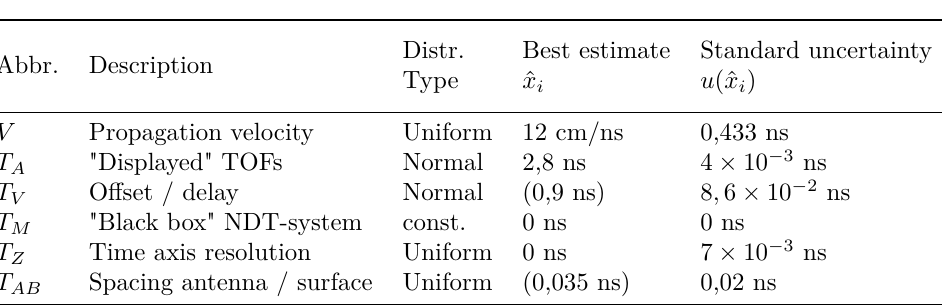
Table 1. Individual models of the input quantities used to compute the measurement result. The biases regarding offset ˆ t V , antenna-surface-spacing ˆ t AB , and transmitter-receiver-spacing were corrected during data migration. evaluated precisely via type B. The spacing ∆ t